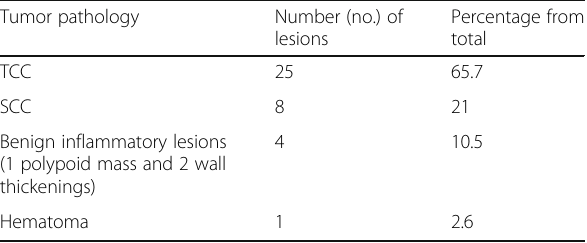
Table 5 The number of lesions according to their histopathological